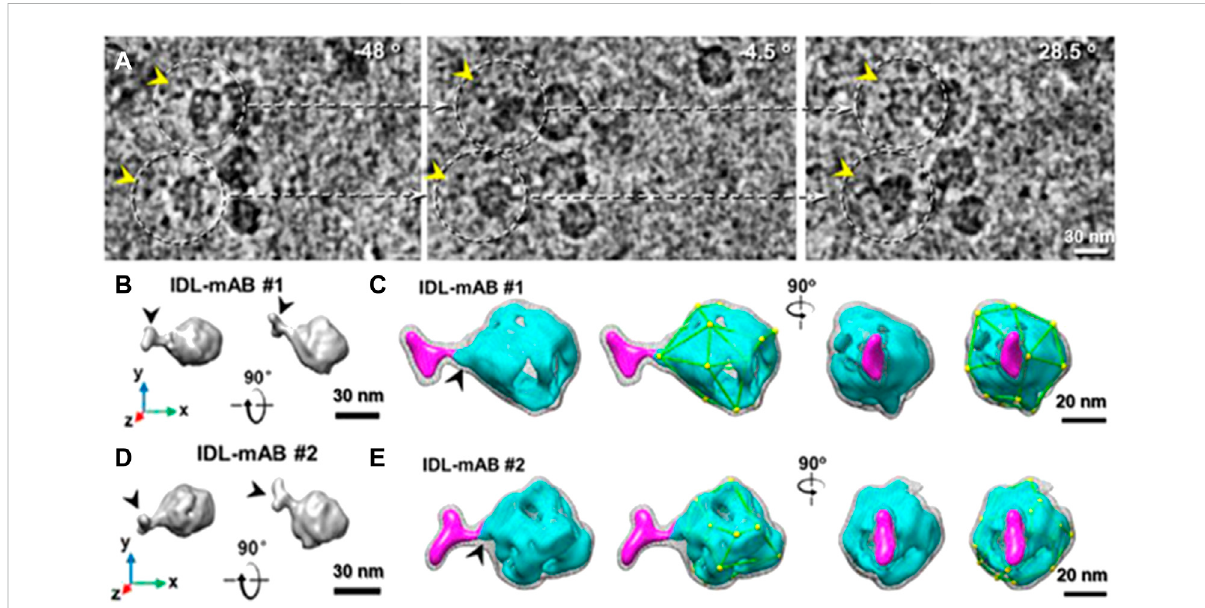
FIGURE 10 Cryo-ET3Dreconstructionofindividualintermediate-densitylipoprotein(IDL)particlesbyIPET. (A) RepresentativeimagesoftiltseriesofIDLby cryo-ET. (B,C) Two representative views of 3D density maps of an individual IDL bound to antibody (mAB) are displayed from two orthogonal views. Maps are shown by two contour levels (high contour level in cyan surface and low contour level in gray mesh). (D,E) The same views for another individual IDL-mAB particle. Surface polyhedral shapes are outlined. Reproduced with permission (Lei et al.,